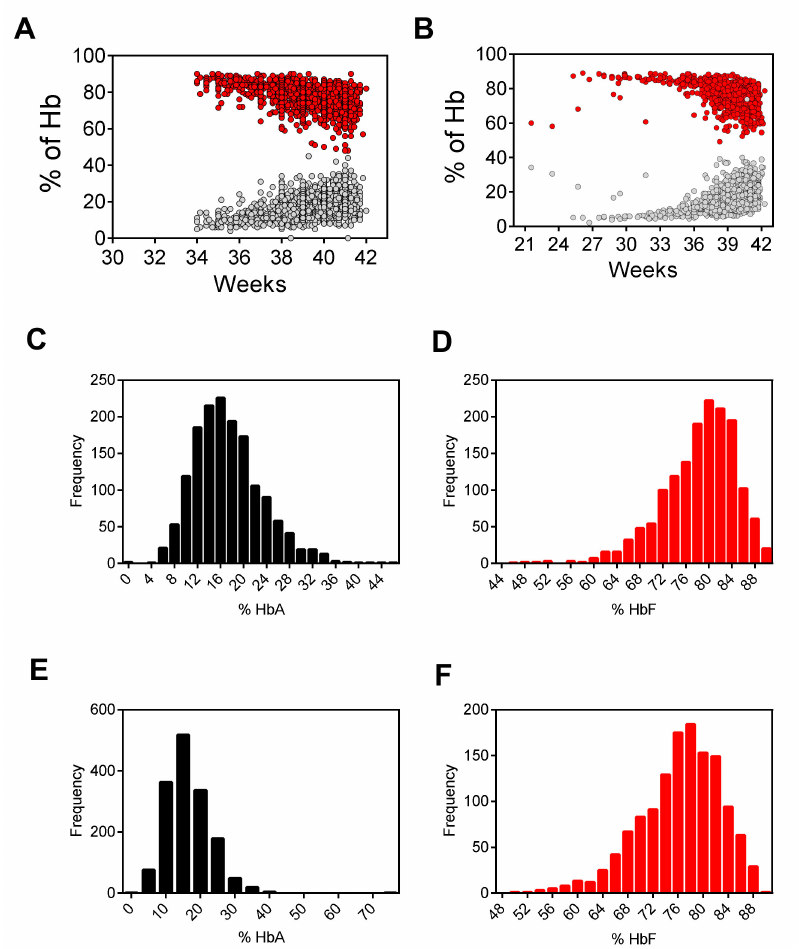
Figure 2. Percentages of HbF (red circles) and HbA (gray circles) according to the gestational age (weeks from conception to blood withdrawal) found in the cohort of Padova ( A ) and Monza ( B ). Distribution frequency of HbA and HbF in the cohort of Padova ( C , D ) and Monza ( E , F